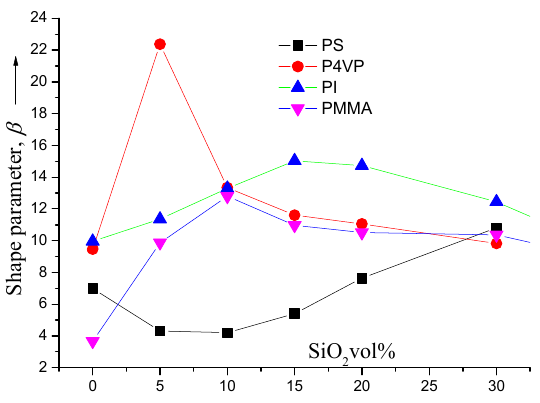
Figure 5. The shape parameter ( β ) as a function of silica content for PS, P4VP, PI and PMMA.